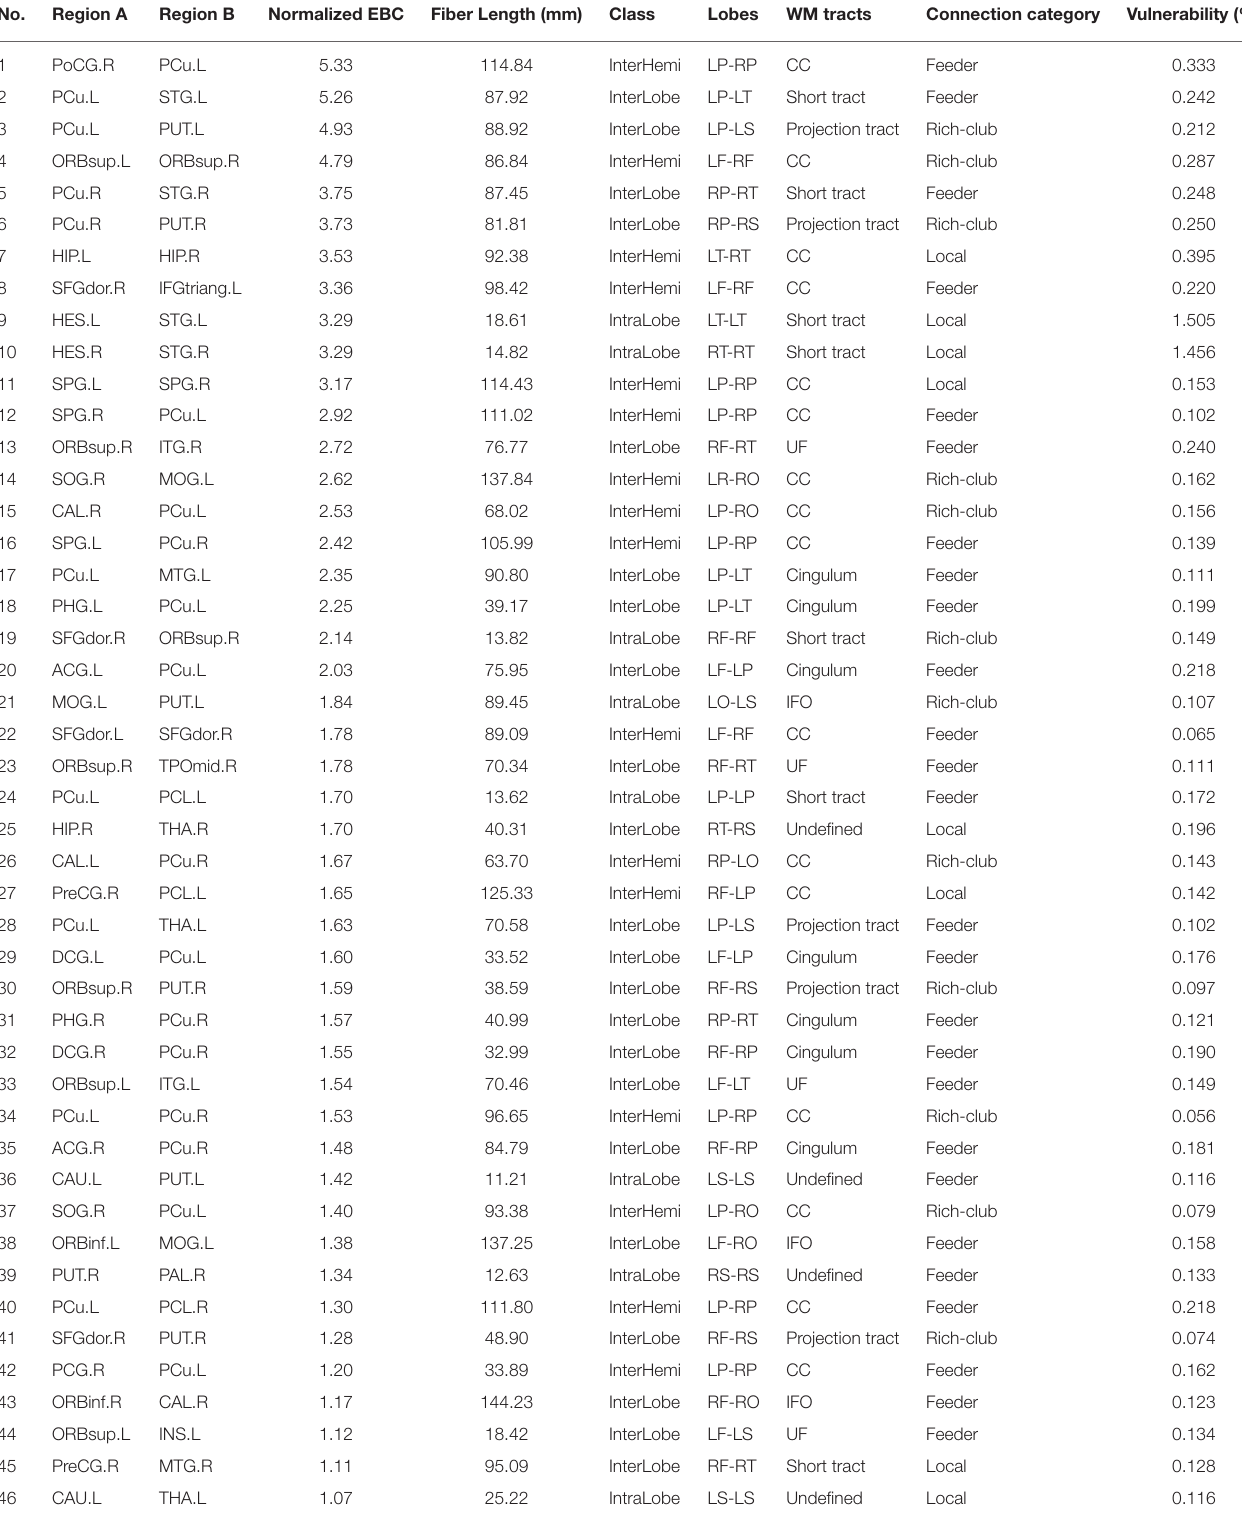
TABLE 1 | The pivotal edges of the human brain WM network and their